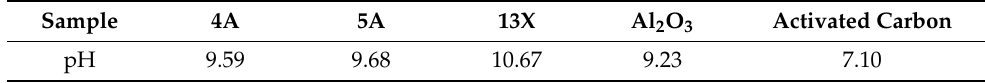
Table 1. pH values of the different blank